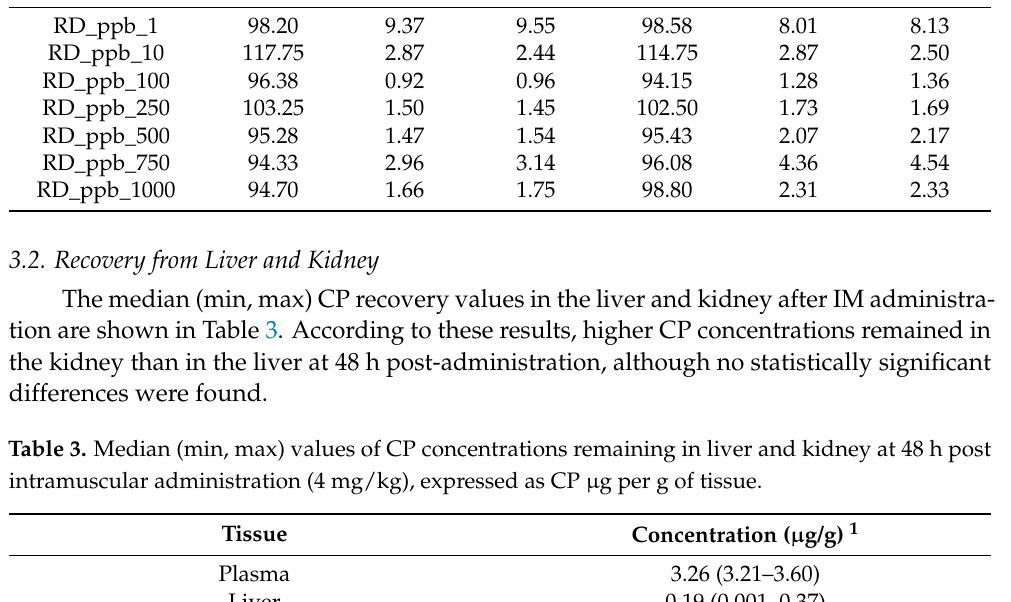
Table 2. Accuracy of the method for transitions T 1 and T 2 expressed by the mean, standard deviation (SD) and relative standard deviation (RSD), for seven concentration levels of standard curves, ranging from 1 ppb (ng/mL) to 1000 ppb. T 1 T 2